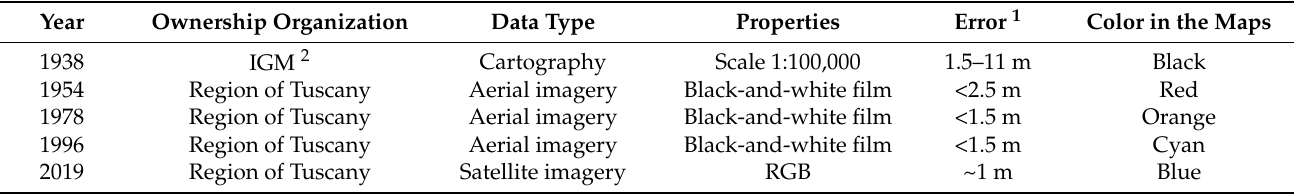
Table 2. The selected shoreline positions with the year of survey, the ownership Organization, type and properties of the origin data, the margin of error of the digitalization and the corresponding color in the